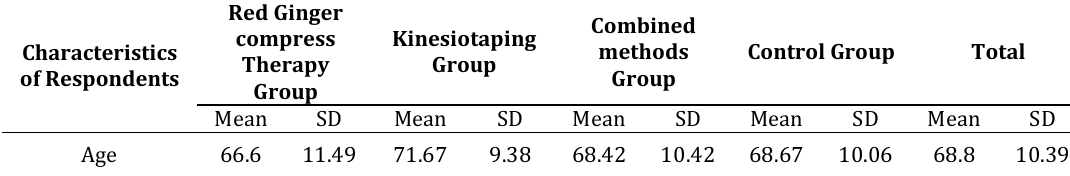
Characteristics of respondents: age